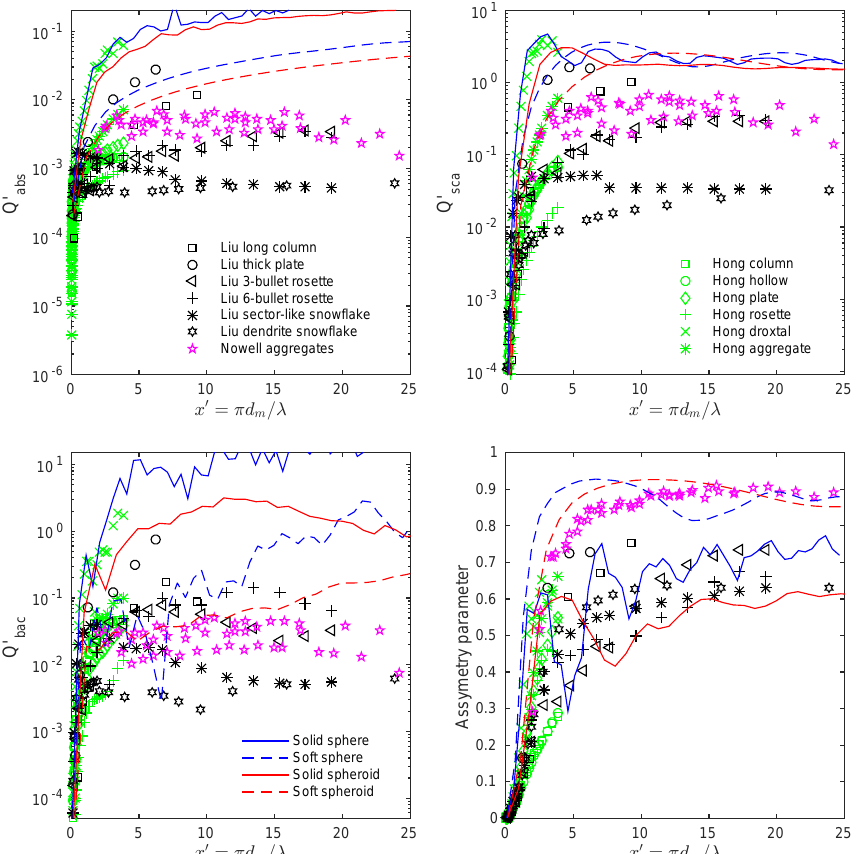
Figure 10. As in Fig. 3 but using the maximum dimension ( d m ) as characteristic size. That is, the size parameter is here defined as x (cid:48) = πd m /λ and absorption and scattering efficiencies are defined as Q (cid:48) = ( 4 σ)/(πd 2 m ) . As in Fig. 3, the frequency is